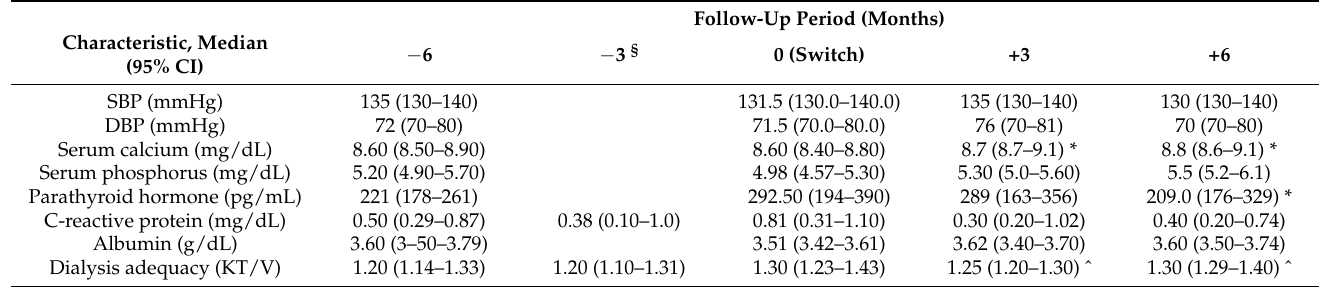
Table 4. Mean levels of arterial blood pressure, biochemical variables and dialytic variables at 3-month intervals with FG and after FCM treatments.